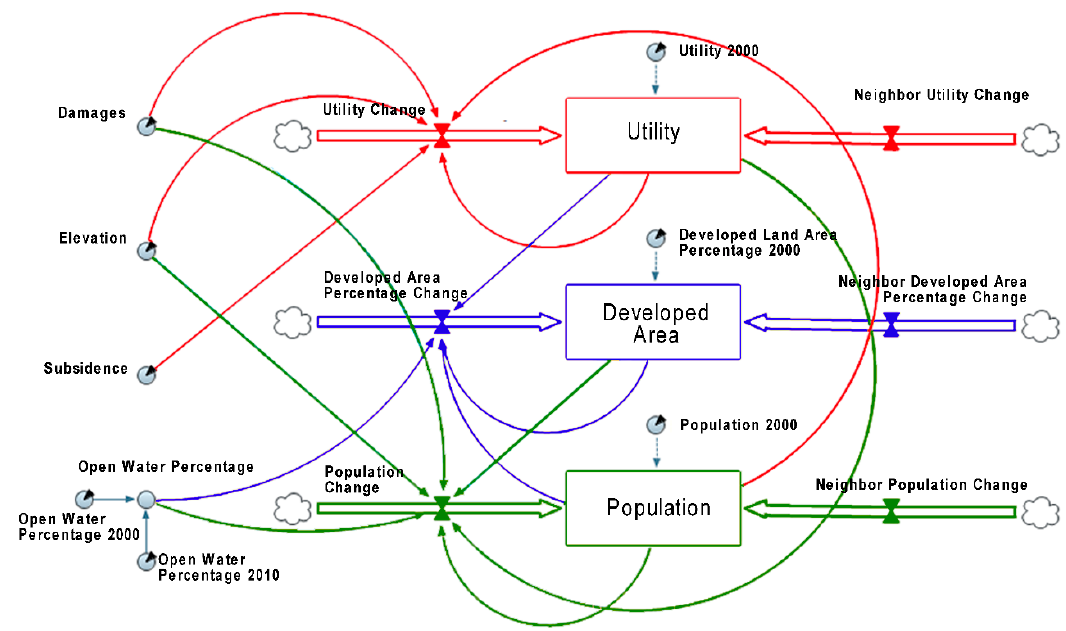
Figure 8. The MRD coupled natural-human (CNH) system dynamic model [47].